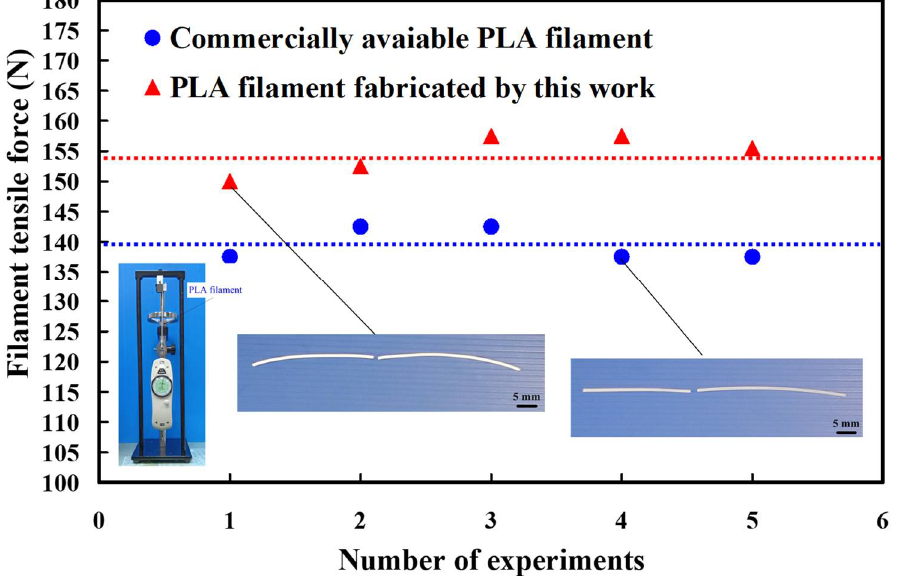
Figure 14. Filament tensile force of the two kinds of PLA filaments.